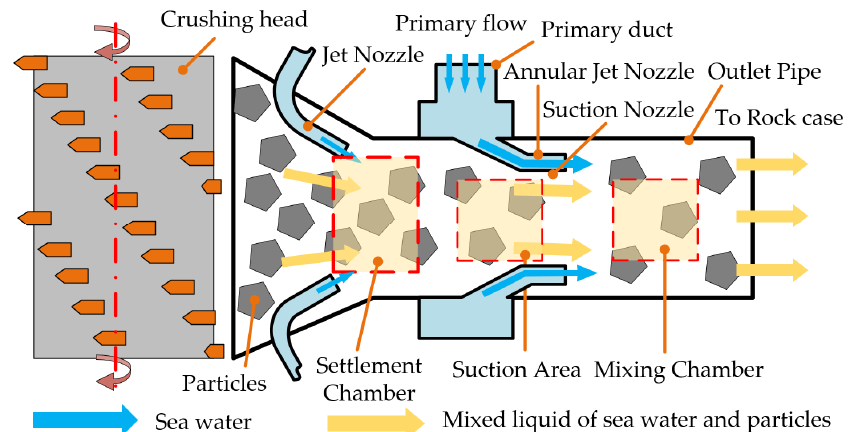
Figure 5. Hydraulic collection schematic diagram. Table 7. Hydraulic collection parameters.